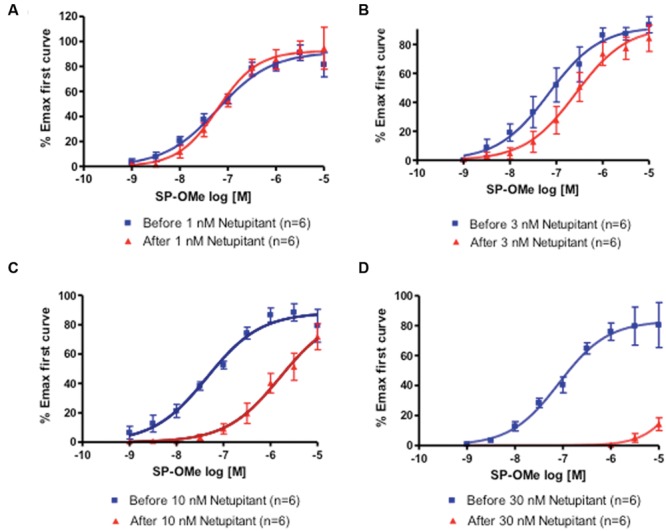
First and second concentration-response curves (CRCs) to SP-OMe in guinea-pig isolated urinary bladders incubated with netupitant at (A) 1 nM; (B) 3 nM; (C) 10 nM; (D) 30 nM.